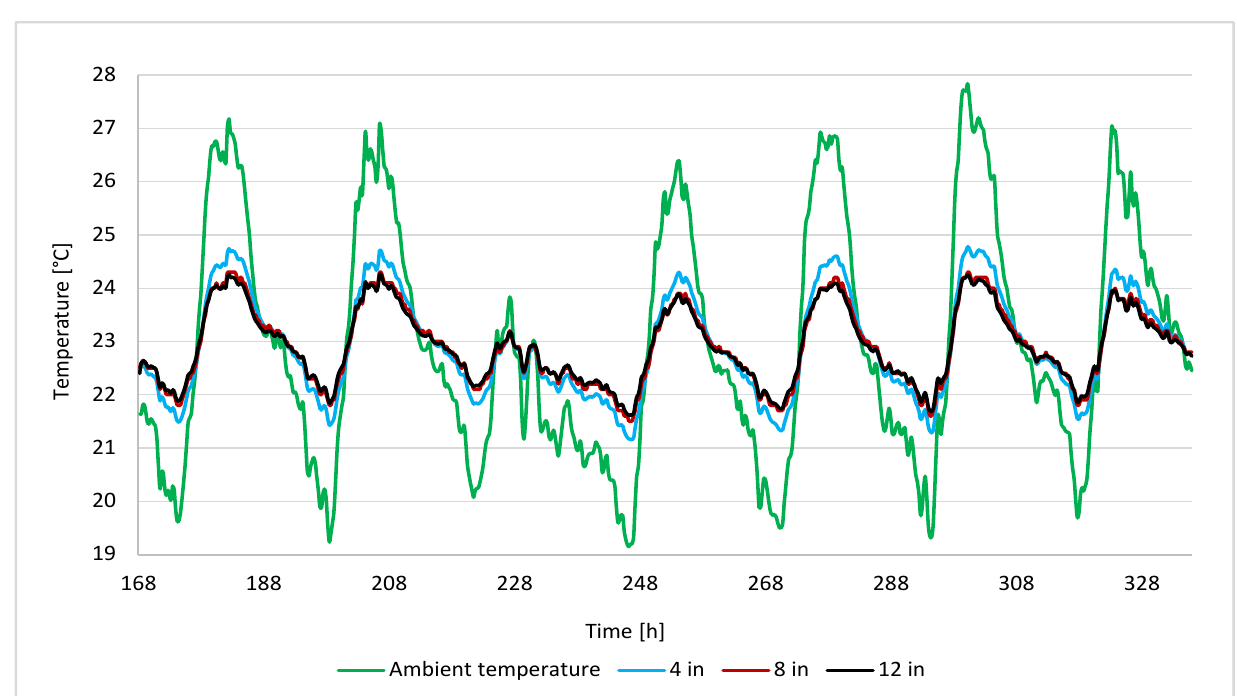
Figure 13. EAHE outlet air temperature vs pipe diameter.